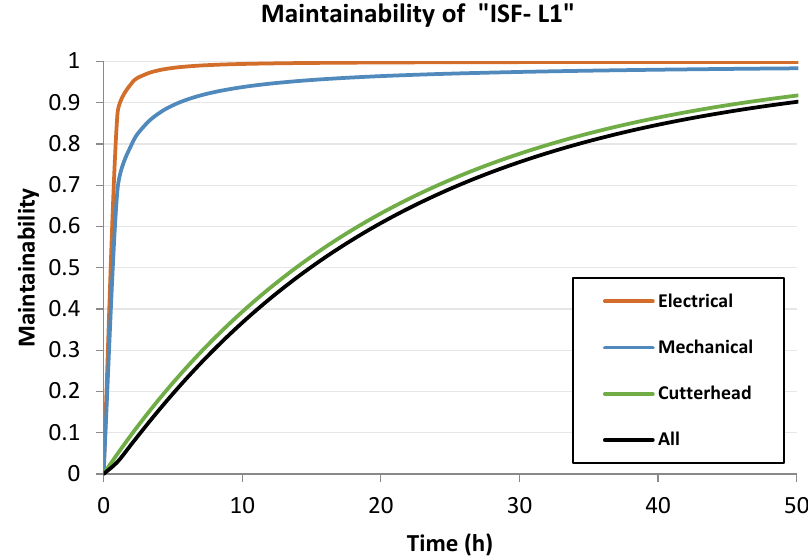
Figure 8. Maintainability of the EPBM and all subsystems in Line 1.